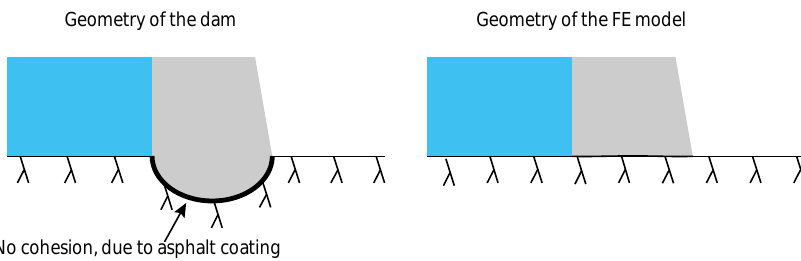
Figure 6. Illustration of the real foundation ( left ) were the dam is excavated into the rock and where cohesion is prevented by an asphalt coating. The idealised geometry in the FE model ( right ).